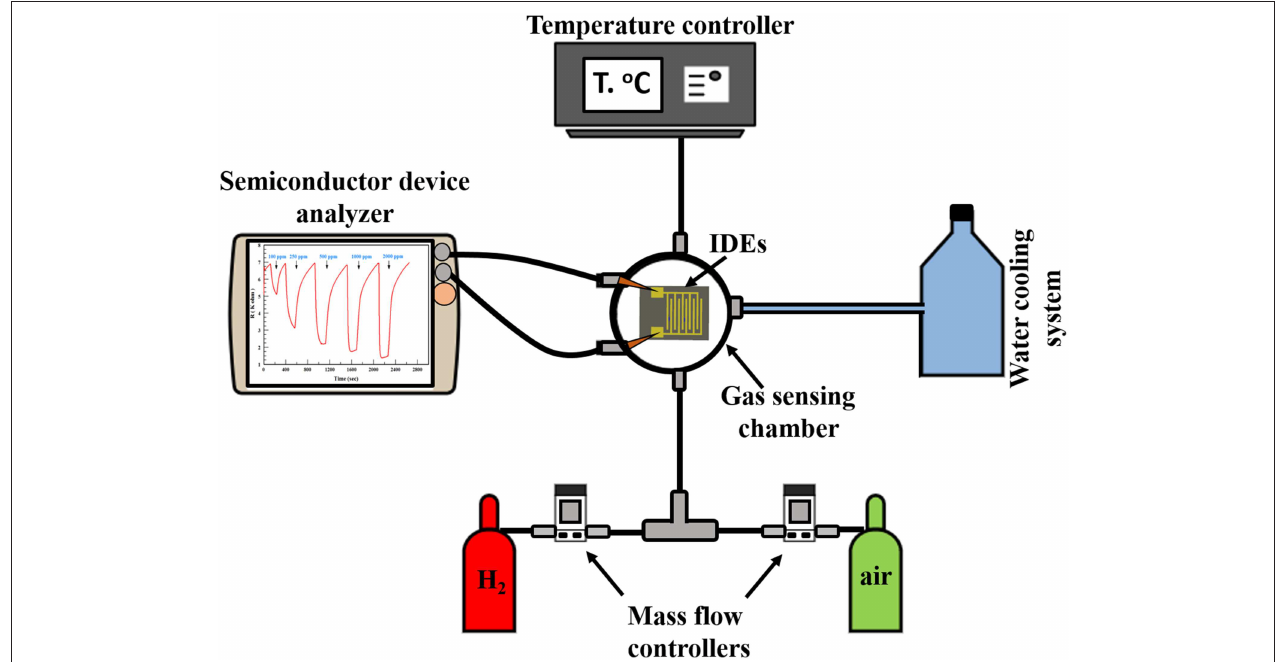
FIGURE 1 | Experimental setup used for sensing